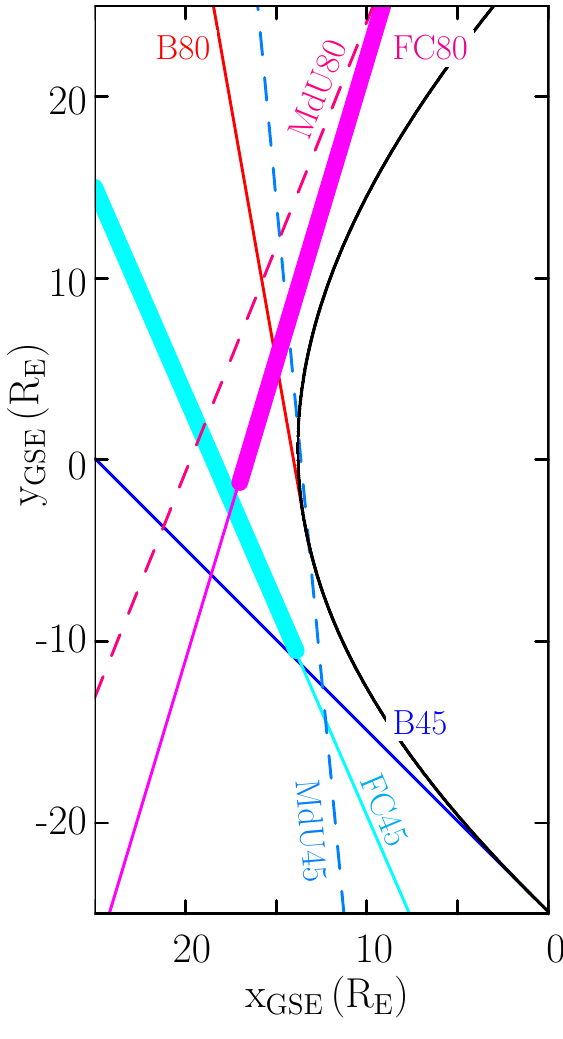
Fig. 6. SFC scatter plot of foreshock cavities observed for IMF cone angles 80 ◦ ± 10 ◦ (red triangles) and those observed for IMF cone angles 45 ◦ ± 5 ◦ (blue circles). The solid line indicates the inter- mediate ion foreshock boundary reported by Meziane and d’Uston (1998) for cone angles of 45 ◦ ± 5 ◦ , and the dashed line the same boundary for cone angles of 75 ◦ ± 5 ◦ . The boundaries reported by ◦ are not Meziane and d’Uston (1998) for cone angles of 75 ◦ and 85 Fig. 7. An illustration of how the boundaries found in Solar Fore- Fig. 7. An illustration of how the boundaries found in Solar Fore- significantly different (the gradients and intercepts of the linear fits shock Coordinates (see Figure 6) would map to the Geocentric Solar shock Coordinates (see Fig. 6) would map to the Geocentric Solar are the same to within the errors reported). As relatively few fore- Ecliptic system if all observations and the solar wind magnetic field Ecliptic system if all observations and the solar wind magnetic field shock cavities are observed for high cone angles, we employ wider were constrained to the ecliptic plane. This schematic shows a sec- were constrained to the ecliptic plane. This schematic shows a sec- bins. tion through the bow shock in the xy GSE plane for high and low tion through the bow shock in the xy GSE plane for high and low IMF cone angles (by construction this plane contains the solar wind IMF cone angles (by construction this plane contains the solar wind bulk flow velocity and the IMF). Solid blue and red lines indicate bulk flow velocity and the IMF). Solid blue and red lines indicate the position of the tangent field line for IMF cone angles of 45 ◦ and the position of the tangent field line for IMF cone angles of 45 ◦ and 80 ◦ (labelled B45 and B80). Dashed lines (MdU45 and MdU80) 80 ◦ (labelled B45 and B80). Dashed lines (MdU45 and MdU80) show the fits, reported by Meziane and d’Uston (1998), to the in- show the fits, reported by Meziane and d’Uston (1998), to the in- termediate ion foreshock boundary. Magenta/cyan lines (FC45 and termediate ion foreshock boundary. Magenta/cyan lines (FC45 and FC80) show linear fits to the locations of observed foreshock cav- FC80) show linear fits to the locations of observed foreshock cav- ities; these lines thicken to indicate the regions in which cavities ities; these lines thicken to indicate the regions in which cavities were actually found. were actually